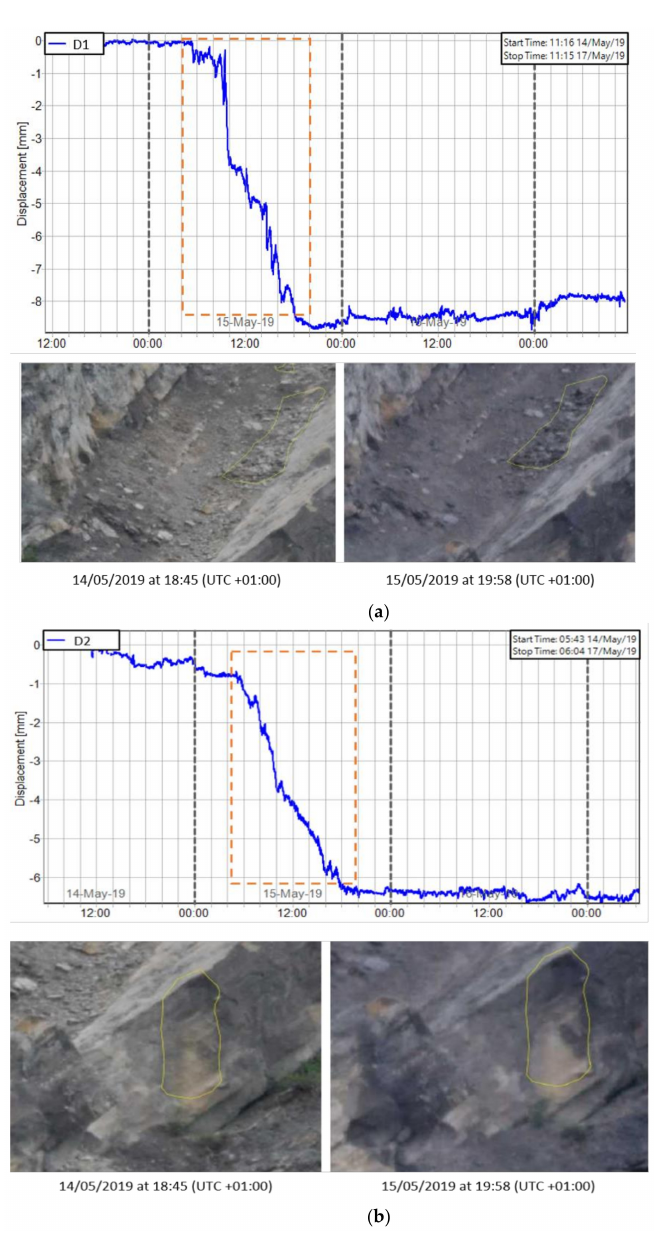
Figure 16. Comparison between radar measurements and Gigapixel analysis for D1 and D2 areas: ( a ) Displacement time series of D1 area measured by radar (above) and pre/post event images taken by GigaPan (below); ( b ) Displacement time series of D2 area measured by radar (above) and pre/post event images by GigaPan